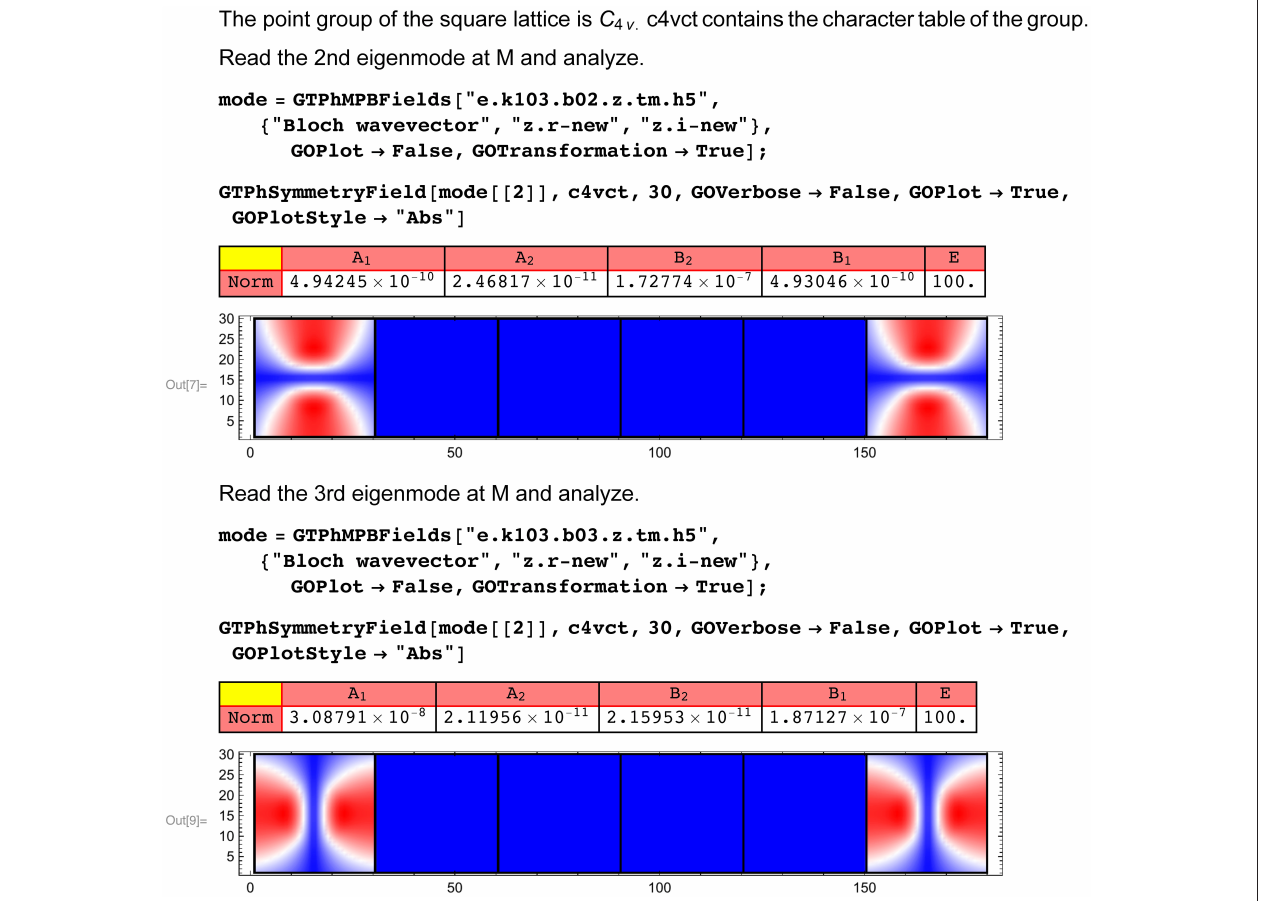
FIGURE 9 | Application of the character projection operator to the field corresponding to the degeneracy between the second and third band of the transversal magnetic mode at M